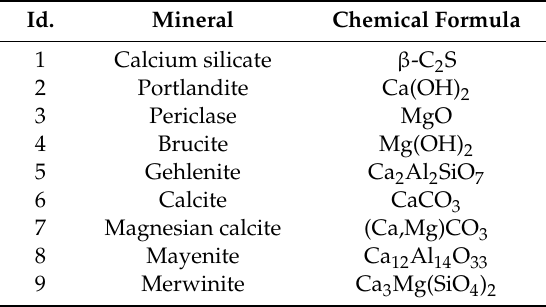
Table 2. Mineral composition of ladle slag